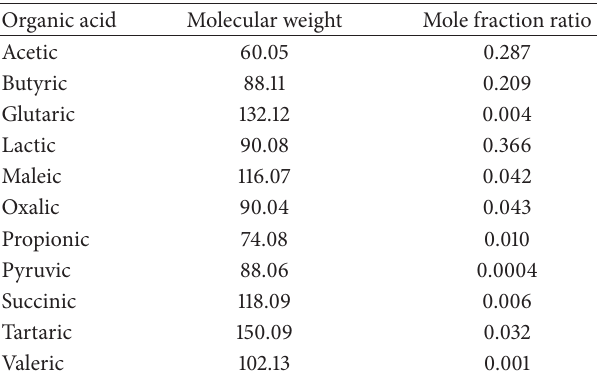
Table 3: Mole fraction of organic acids collected in root exudates of